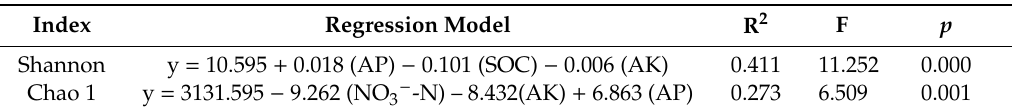
Table 2. Results of stepwise regression for the e ff ects of soil properties on the alpha diversity of bacterial communities. AP, available phosphorus; SOC, soil organic carbon; AK, available potassium.